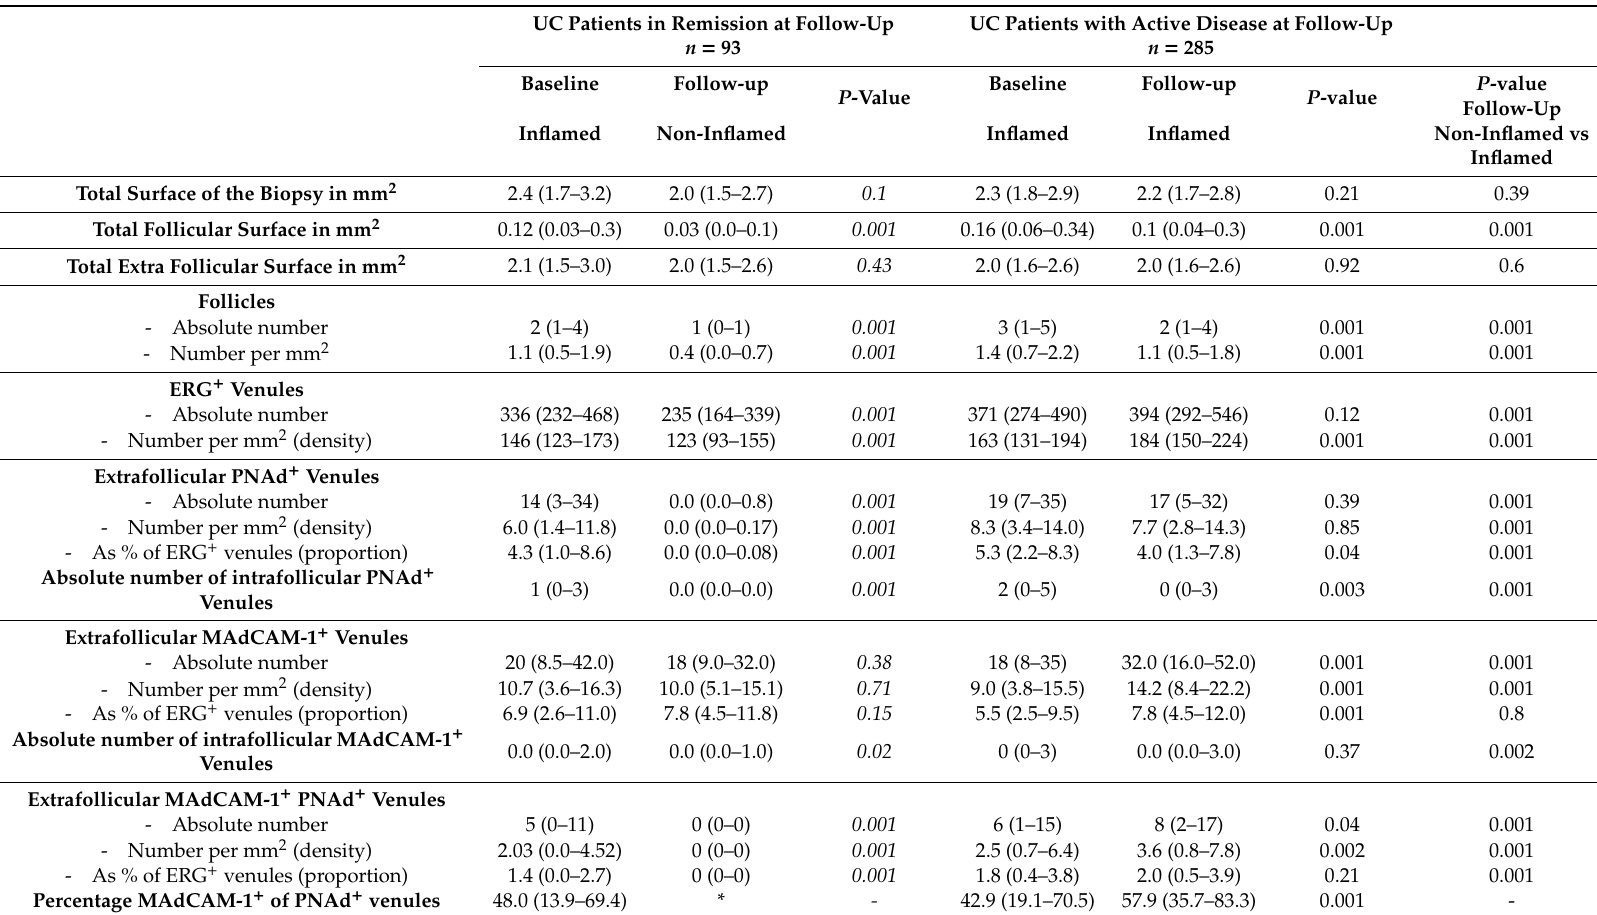
Table 3. The presence of follicles and (PNAd + , MAdCAM-1 + , ERG + ) venules in inflamed and non-inflamed colonic biopsies of UC patients at follow-up